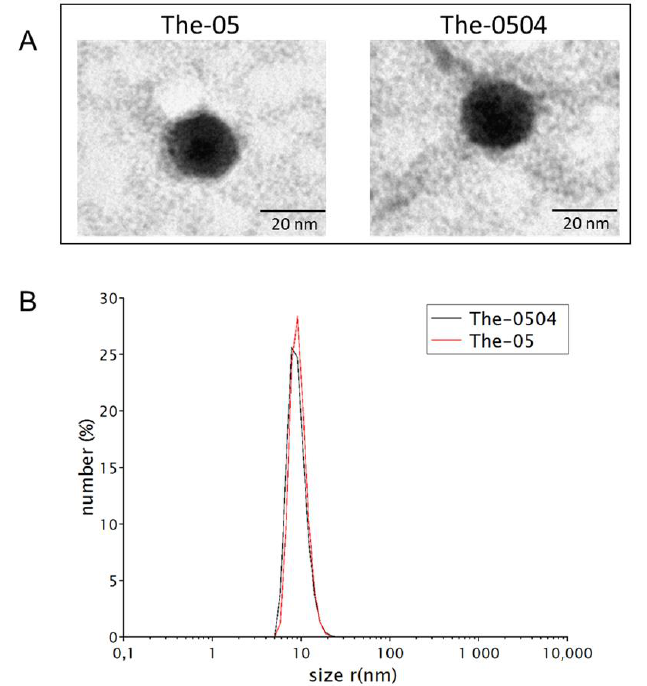
Figure 3. Biophysical characterization of the The-05 nanocarrier before and after Genz-644282 encapsulation. ( A ) Representative TEM images of negatively stained The-05 (left) and The-0504 (right), showing the spherical shape typical of ferritin-like proteins. ( B ) Dynamic light scattering profiles of The-05 (red) and The-0504 (black).